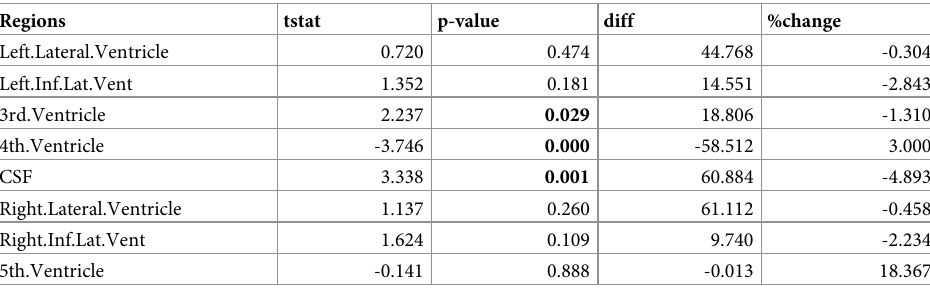
Differences are Anesthesia (A2)—Day 7. Significant differences highlighted in